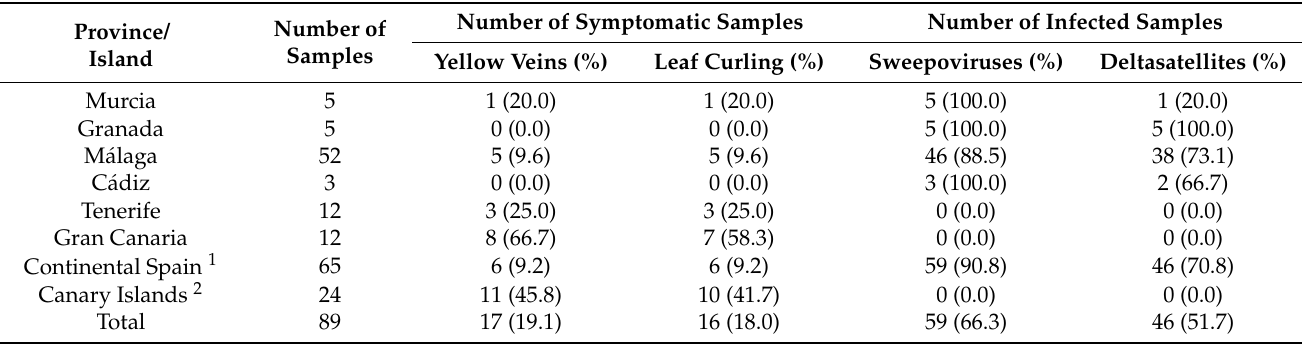
Table 1. Ipomoea indica samples analyzed in this study. Additional details are given in Table S1.